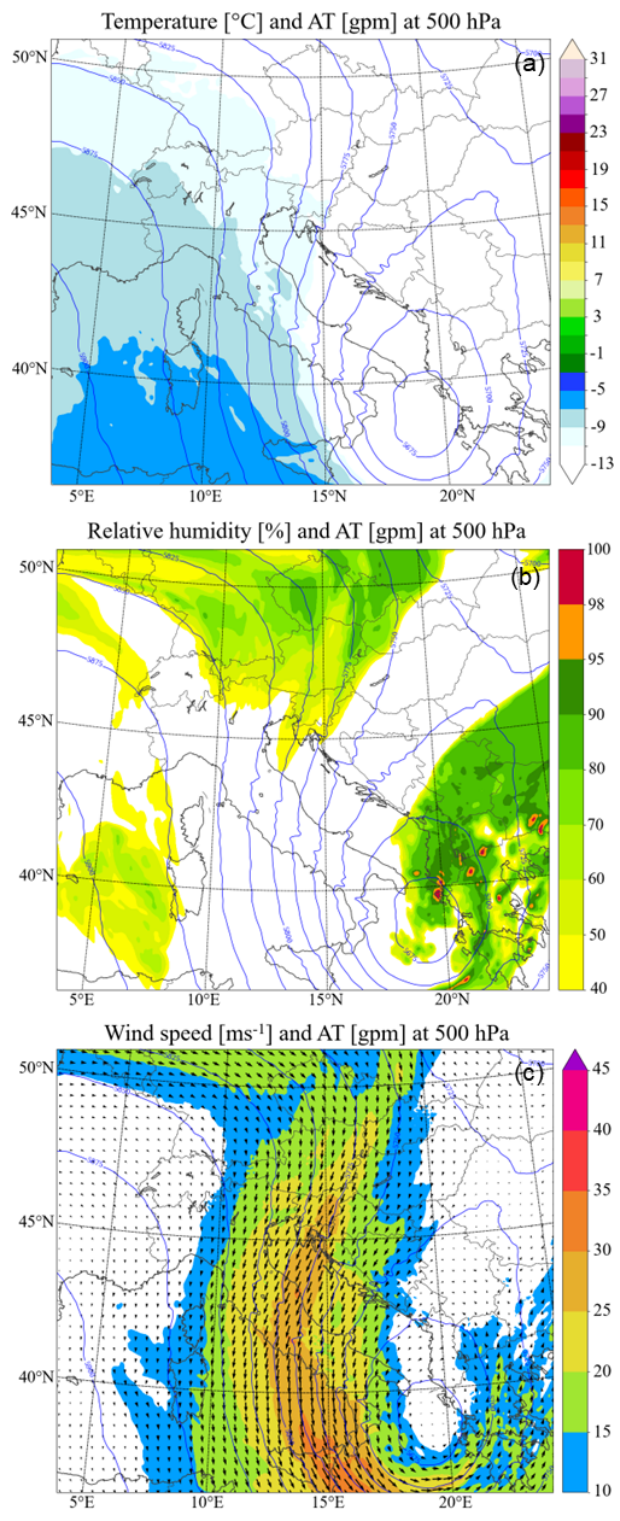
Figure 7. (a) Temperature ( ◦ C; colored), (b) relative humidity (%; colored), and (c) wind speed (ms − 1 ; colored), all including geopotential height (AT) (gpm; blue contours) at 500hPa from the ALADIN-HR44 model valid for 16 July 2017 at 23:00UTC.